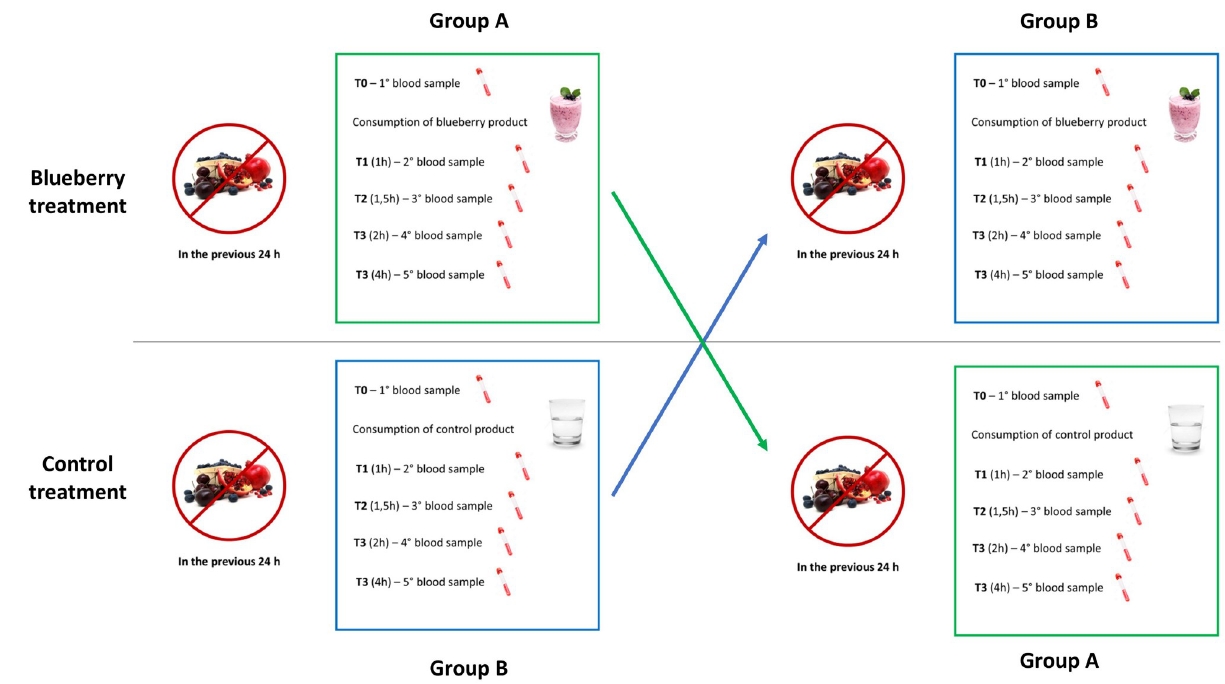
Fig 2. Schematic representation of the study design for the evaluation of blueberry bioactive absorption and of different metabolic/functional markers (phase 1).